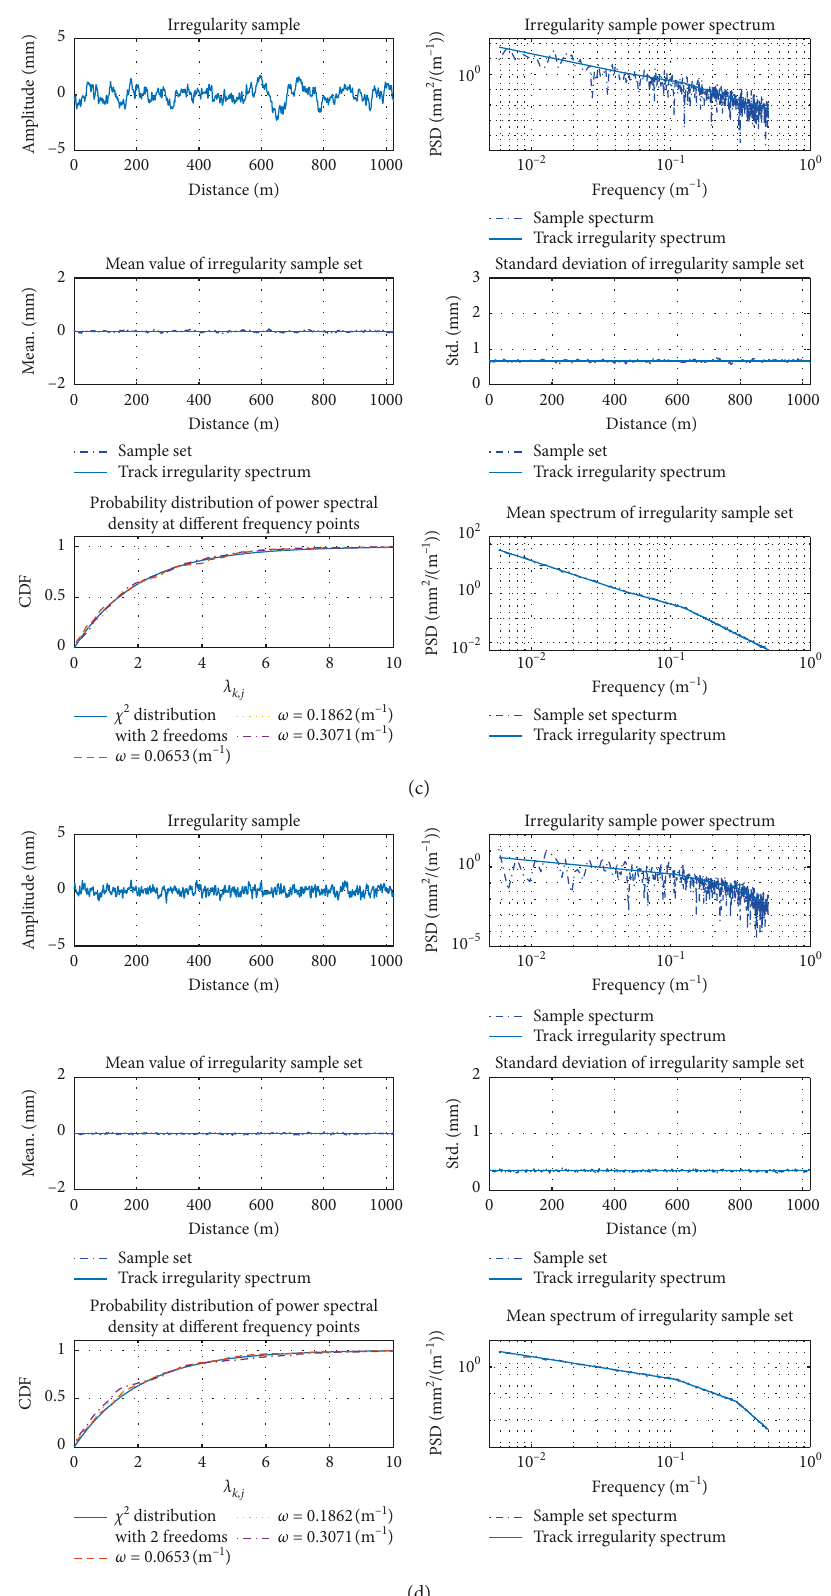
Figure 10: Comparison of track irregularity samples. (a) Vertical profiles of track irregularities, (b) track alignment irregularities, (c) track cross-level irregularities, and (d) track gage